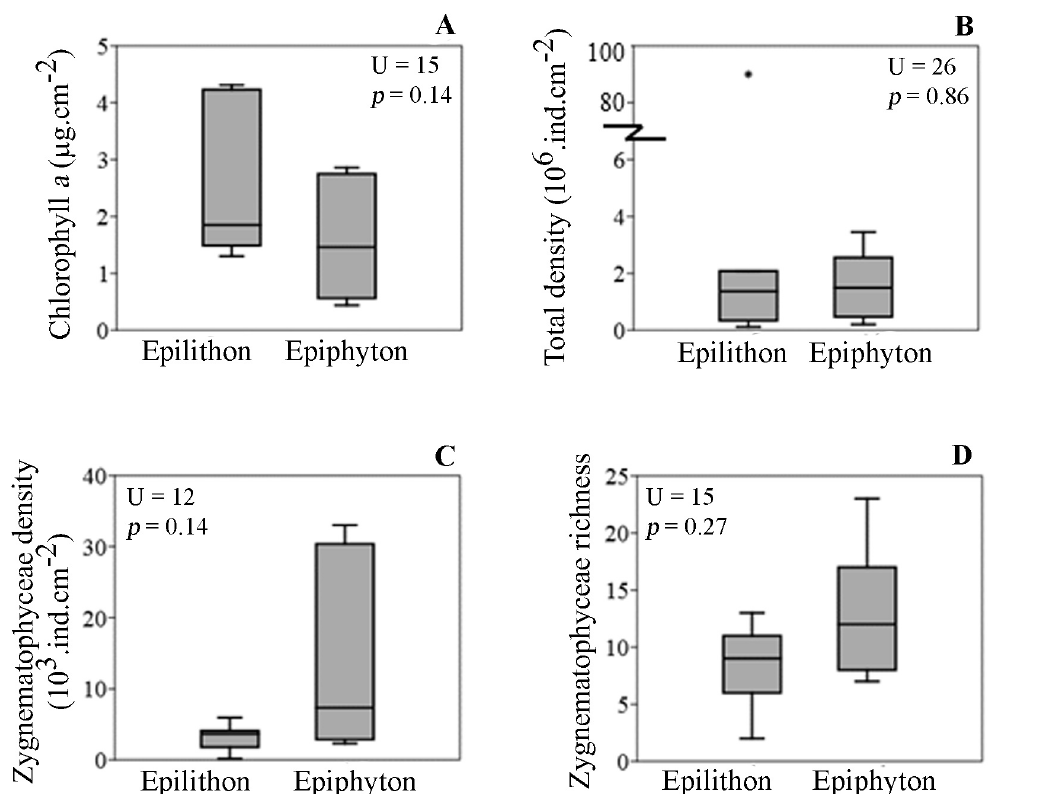
Figure 3. Box-plots of chlorophyll a (A), total density (B), Zygnematophyceae density (C) and Zygnematophyceae richness (D) in the epilithon and epiphyton of nine urban eutrophic ponds from Goiânia, GO.